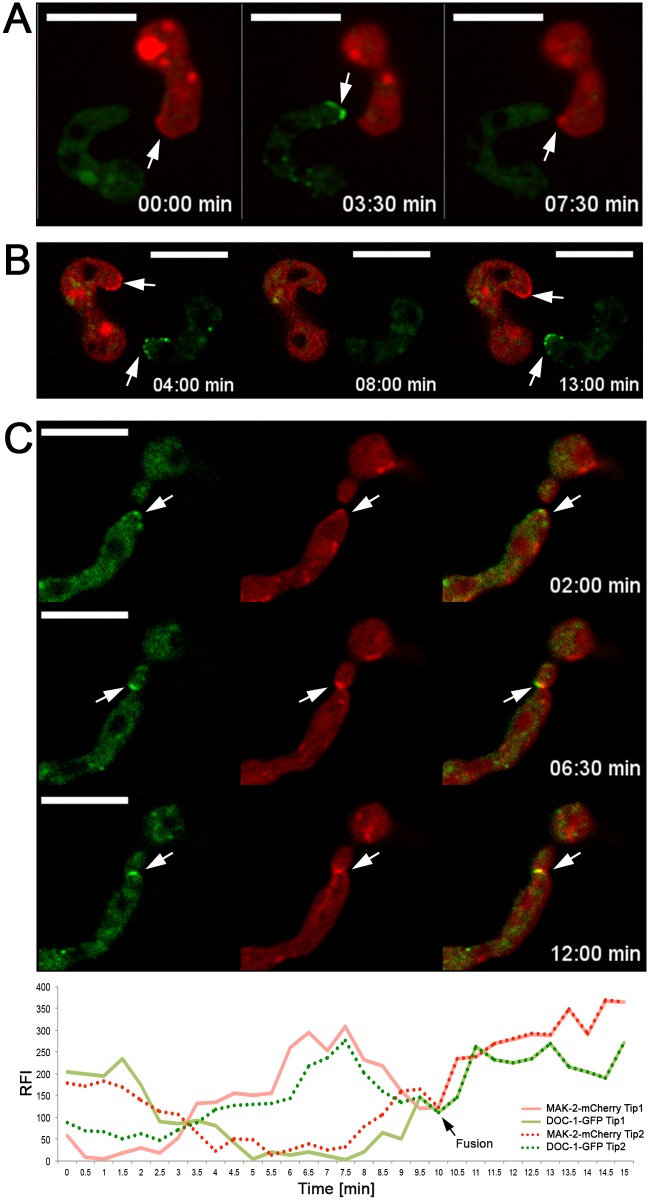
DOC-1-GFP co-oscillates with MAK-2 during chemotropic interactions.(A) Germlings expressing DOC-1-GFP (green) were paired with germlings expressing MAK-2-mCherry (red). When MAK-2-mCherry accumulated at one CAT tip (arrows left and right panel), DOC-1-GFP was absent from the tip of the interacting germling. When DOC-1-GFP accumulated at the second CAT tip (arrow middle panel), MAK-2-mCherry was absent from the first CAT tip, indicating that DOC-1-GFP showed identical oscillation dynamics to MAK-2-mCherry. (B) Germlings expressing DOC-1-GFP (green) were paired with germlings expressing SOFT-mCherry (red). When SOFT-mCherry accumulated at one CAT tip, DOC-1-GFP accumulated at the CAT tip of its interacting partner (arrows left and right panel). When SOFT-mCherry was absent from the first CAT tip, DOC-1-GFP was absent from the second CAT tip (middle panel), indicating that DOC-1-GFP showed opposite oscillation dynamics to SOFT-mCherry. See S5B Fig for oscillation intervals. (C) Co-localization and co-oscillation of DOC-1-GFP (left panel) with MAK-2-mCherry (middle panel) in heterokaryotic germlings undergoing chemotropic interactions (overlay, right panel). Bottom panel: Graphic representation of DOC-1-GFP and MAK-2-mCherry signals at the tips of conidial anastomosis tubes in germlings undergoing chemotropic interactions. y-axis shows the ratio of relative fluorescence intensity (RFI) in the interacting zone as compared to background. x-axis shows time (min). Note the co-oscillation of both DOC-1-GFP and MAK-2-mCherry in both germlings following fusion, as shown previously for MAK-2 and SOFT [45].